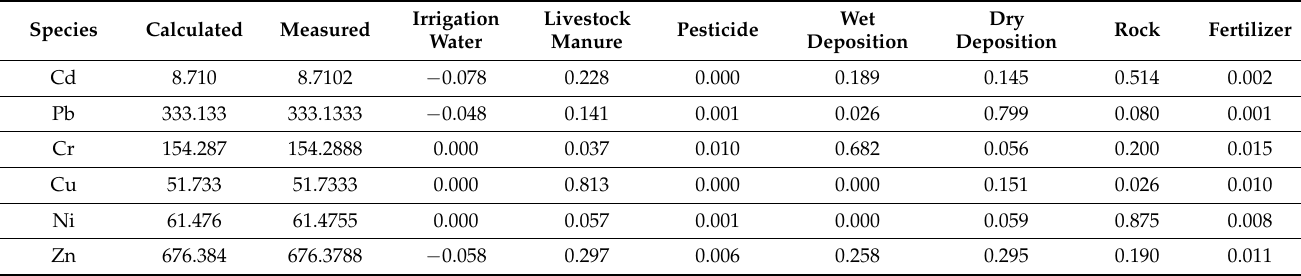
Table 4. Calculation results of CMB